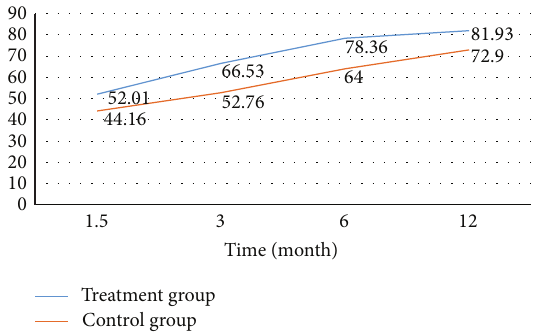
Figure 2: Intergroups changes on the Harris hip scores for 12